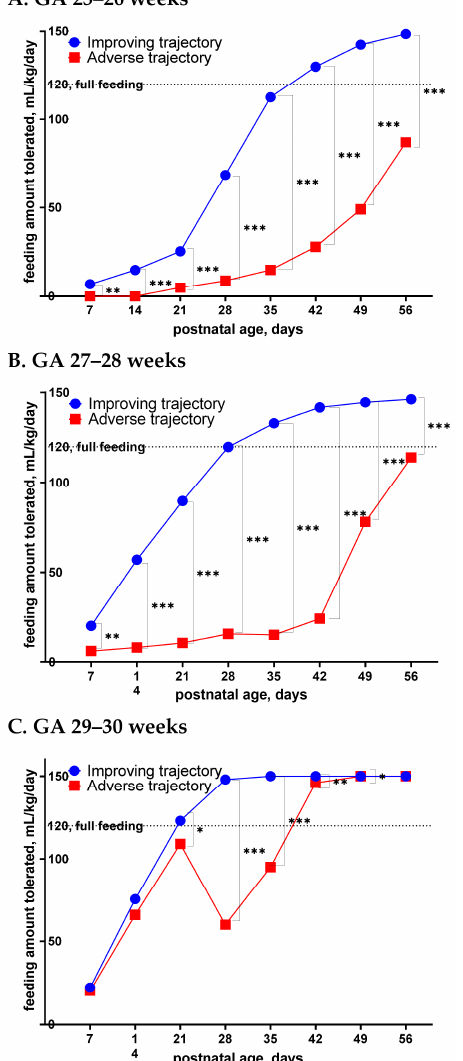
Figure 2. Differences of the median enteral feeding volumes in the first 56 postnatal days of life between the improving pattern and the adverse pattern in infants at GA 23–26 weeks ( A ), 27–28 weeks ( B ), and GA 29–30 weeks ( C ). * p < 0.05; ** p < 0.01; *** p < 0.001. Compared to the improving feeding group, the adverse feeding group was signifi- cantly lower in gestational age, had higher rates of respiratory/hemodynamic morbidities, including hypotension requiring vasopressors, hs-PDA requiring surgery, late-onset sepsis and a longer duration requiring IMV, and GI morbidities, such as non-NEC events requir- ing surgery in infants at GA 23–26 and 27–28 weeks. The adverse feeding group also had significantly higher rates of NEC GI morbidities, including stage 1 and severe NEC in infants at GA 27–28 and 29–30 weeks (Table